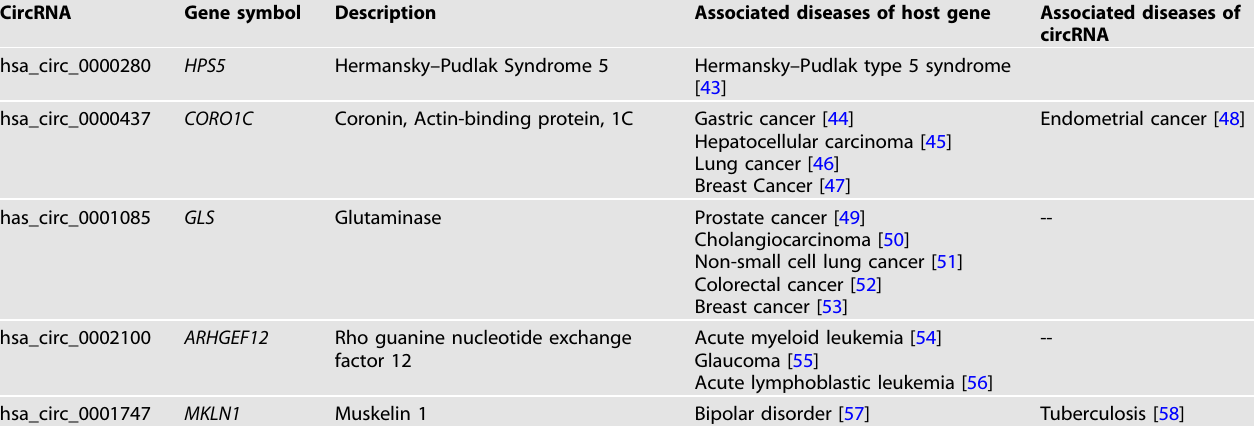
Table 2. Recent studies of fi ve autophagy-related circRNAs and their corresponding host genes.